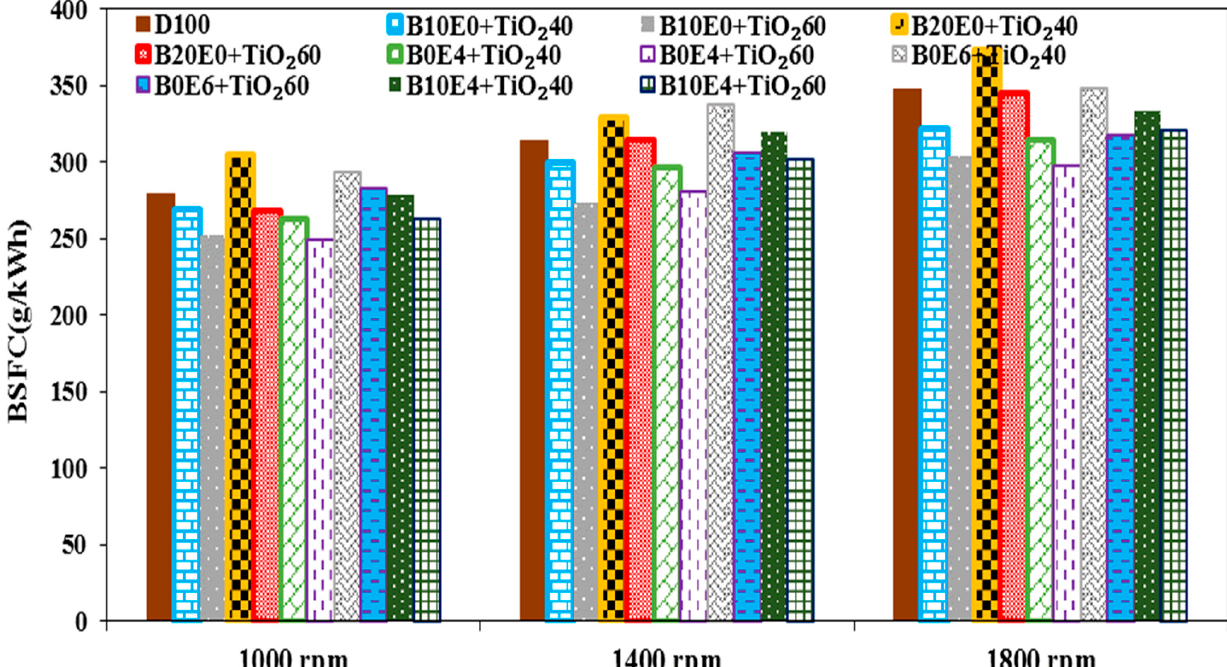
Figure 6. Variation of BSFC for diesel/ethanol/biodiesel blends at TiO 2 = 40, 60 ppm, and various engine speeds.